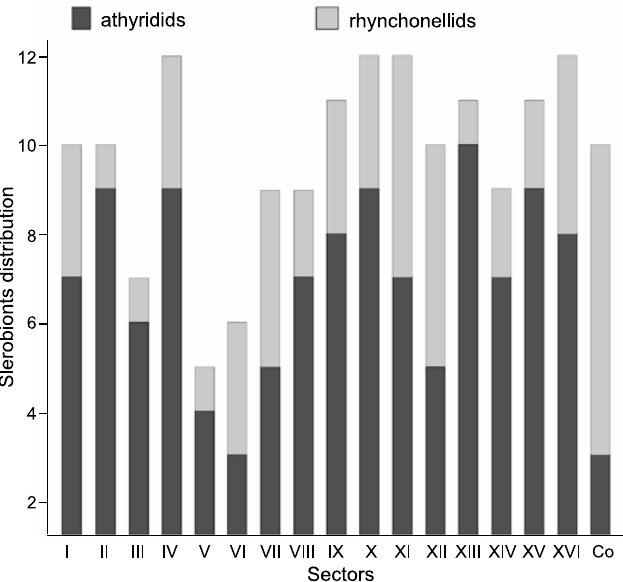
Fig. 6. Abundance of epibionts per sector on both rhynchonellids and athyridids. Co,